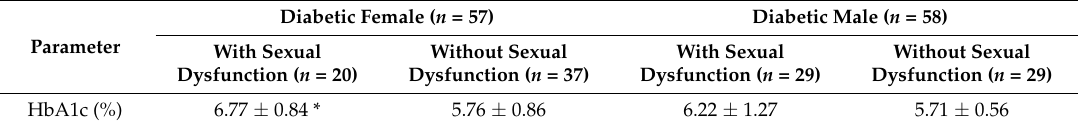
Table 5. Glycated hemoglobin (HbA1c) distribution in diabetic patients with and without sexual